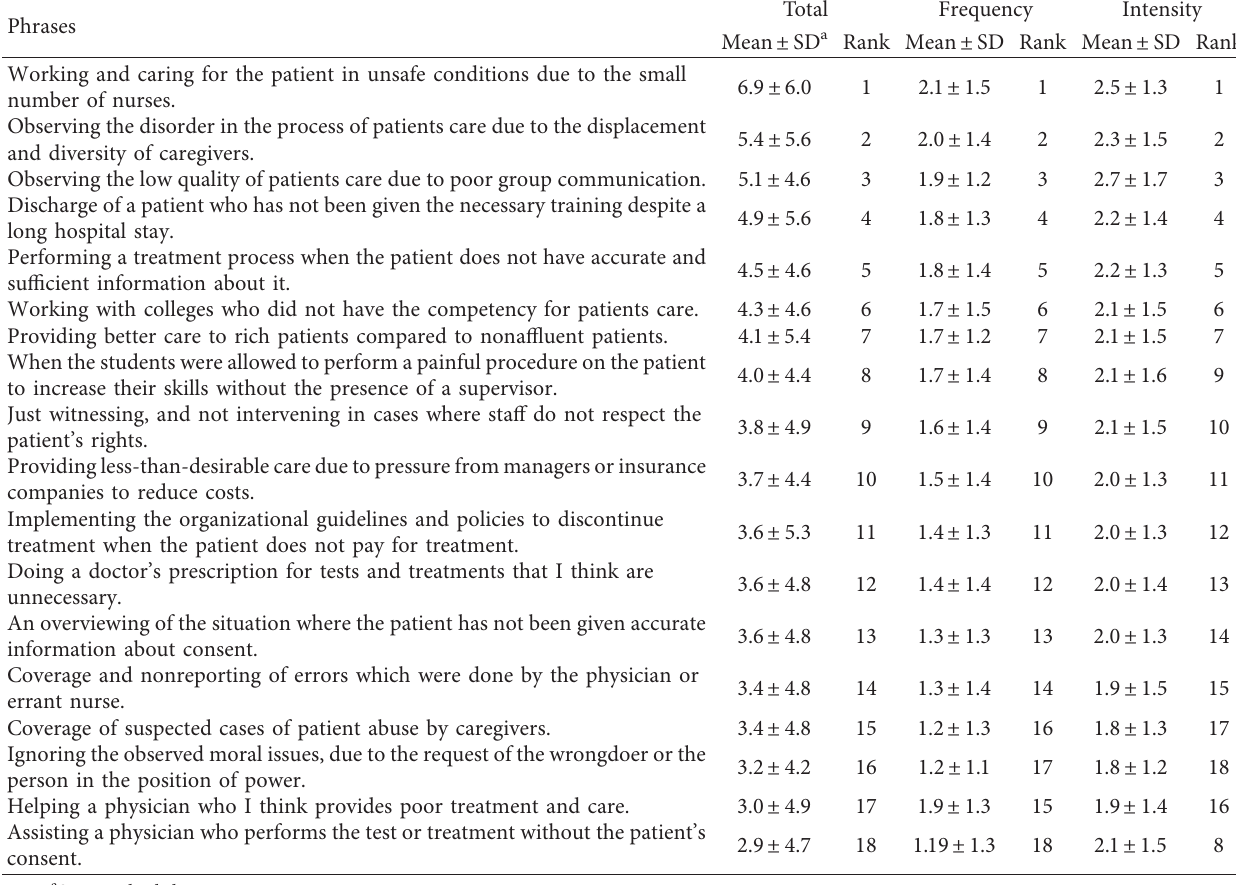
Table 3: The most important factors influencing students’ moral distress.